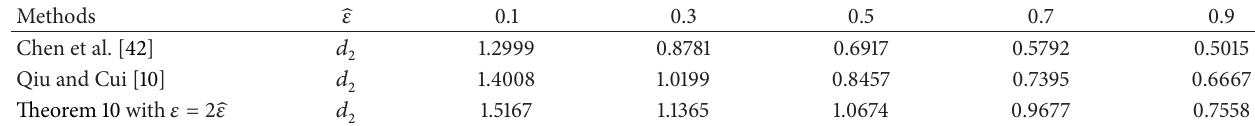
Table 3: Maximum upper bound of 𝑑 2 with different 𝜀 and parameter 𝜇 = 0 .